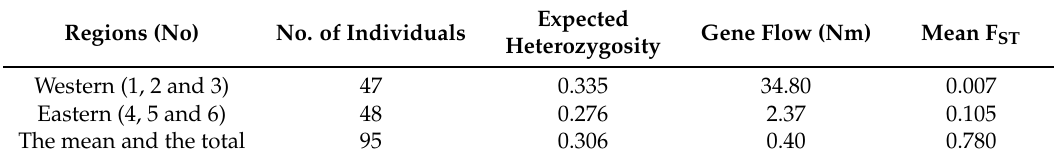
Table 5. Summary of the genetic diversity analyses of A. conjugella in Southern Norway based on 410 AFLP polymorphic bands. Expected Regions (No) No. of Individuals Gene Flow (Nm) Mean F ST Heterozygosity Western (1, 2 and 3) 47 0.335 34.80 0.007 Eastern (4, 5 and 6) 48